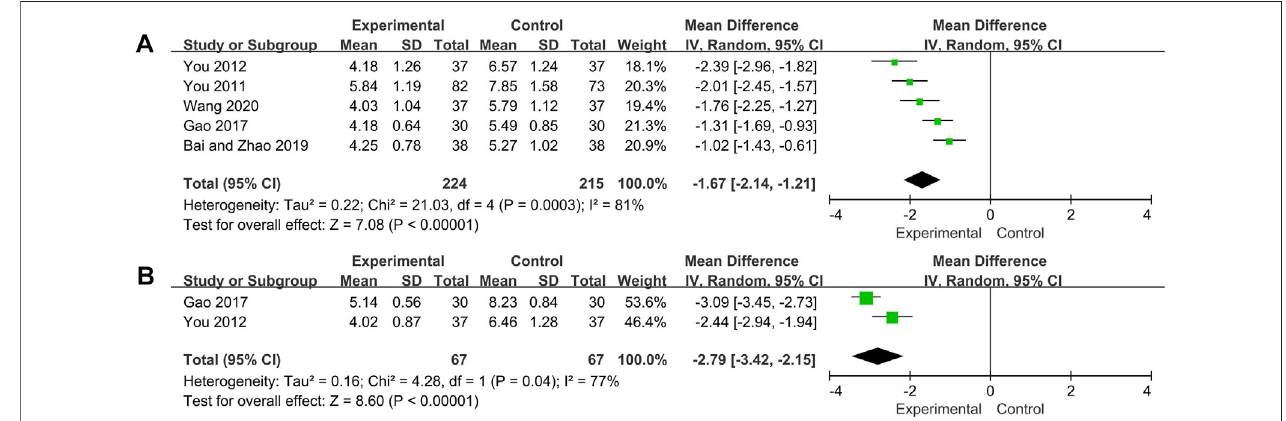
FIGURE 4 | Forest plot of SLEDAI scores (A) and TCM symptoms scores (B) .